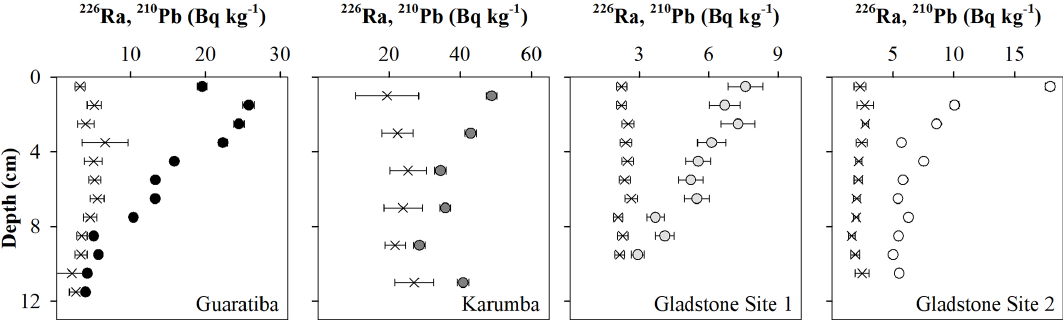
Figure 2. The 226 Ra ( × ) and 210 Pb (circles) depth profiles of the four hypersaline tidal flat sediment cores in this work. Error bars indicate counting uncertainties.